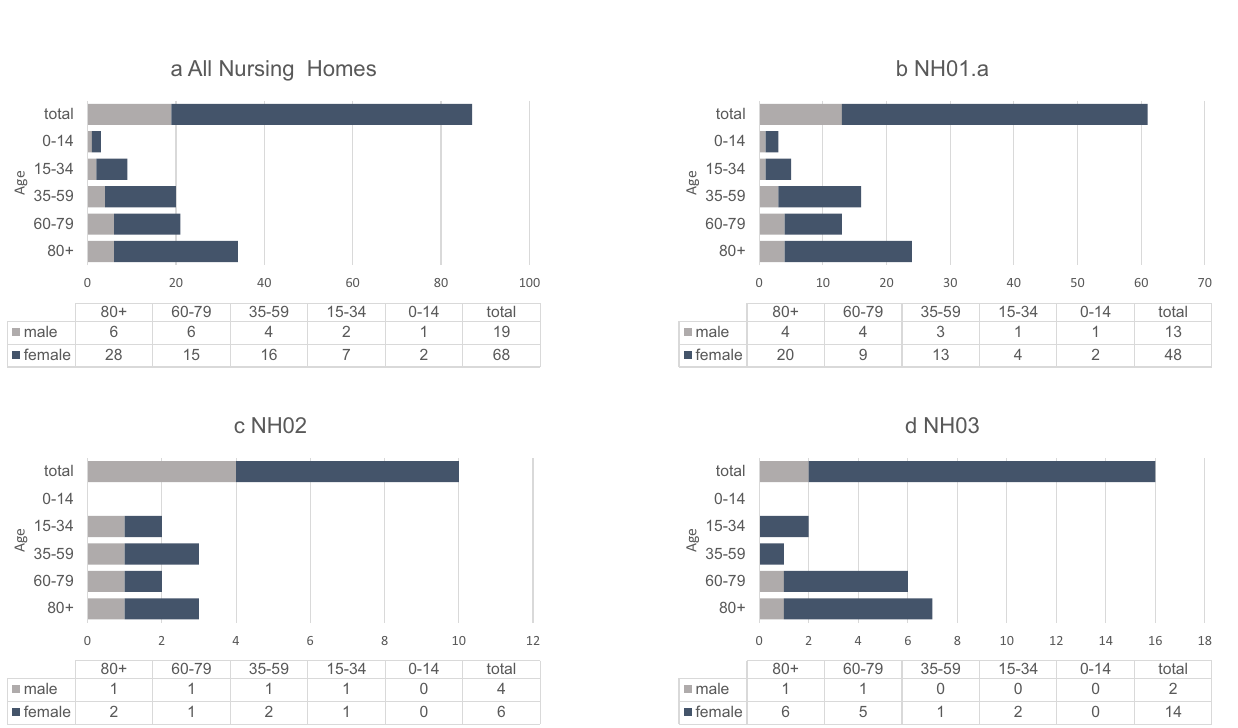
Figure 5. Overview of age and sex distribution among COVID-19 confirmed cases connected with outbreaks in three nursing homes. ( a ) Age and sex distribution of confirmed COVID-19 cases among residents and staff collected of the three nursing homes NH.01a, NH02, and NH03. ( b ) Age and sex distribution of confirmed COVID-19 cases among residents and staff of the nursing home NH.01a. ( c ) Age and sex distribution of confirmed COVID-19 cases among residents and staff of the nursing home NH02. ( d ) Age and sex distribution of confirmed COVID-19 cases among residents and staff of the nursing home NH03. Data are given as n numbers of each age